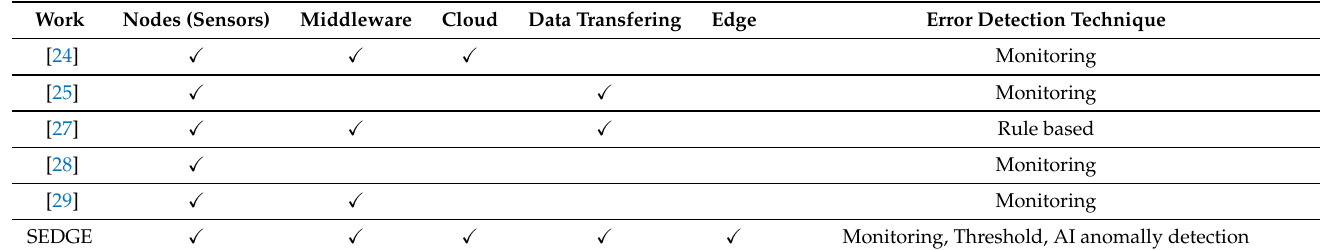
Table 2. Summary of related work and comparison of healing parameters to